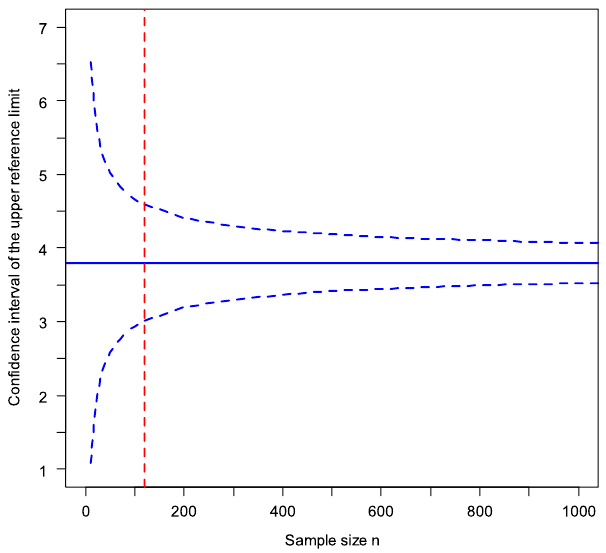
Figure 3: Confidence limits (90%) of the upper reference limit in relation to the number of observations in the case of a log-normal distribution of thyrotropin